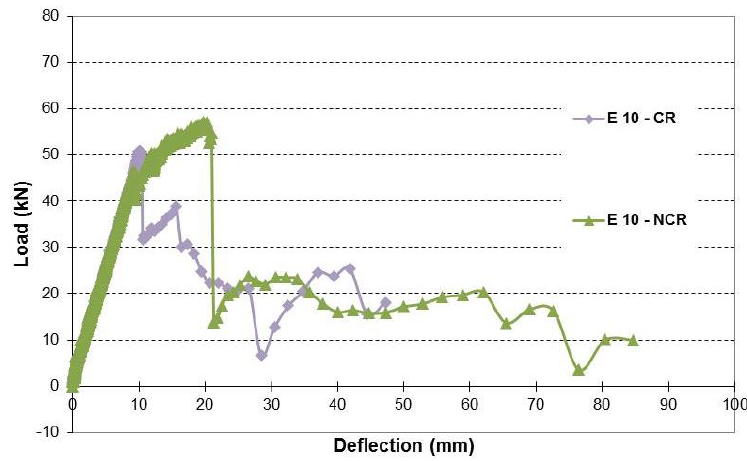
Figure 23. Load-deflection relationship of repaired beams with 10% corrosion level with and without cover.